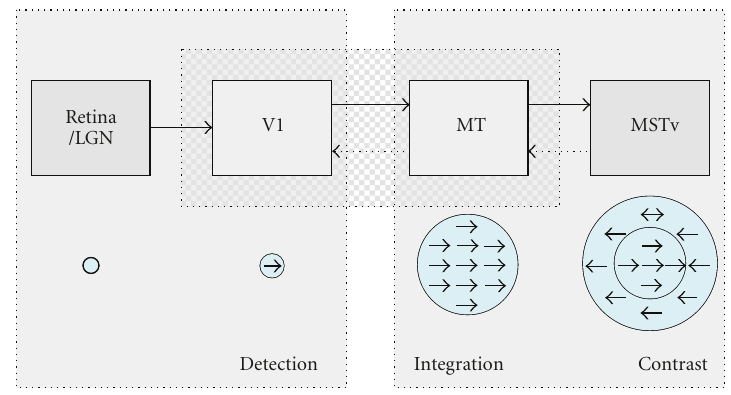
Figure 5: Box-and-arrow representation presenting an overview of neural connection and interaction scheme based on di ff erent cortical areas. Input images are fed forward from LGN into model area V1, where they undergo a filtering with a bank of orientation selective filters to extract local structure in an image frame. Performing a spatiotemporal correlation with these local response energies generates an initial motion signal which is forwarded to model area MT. In area MT a population code is generated to encode motion speed and direction. This integrated motion signal is further delivered to model area MSTv that may detect discontinuities in the flow field of motion vectors. The modelling framework presented here focuses on the interactive processing of motion information at the level of areas V1 and MT. We have highlighted this by the dashed grey box in the center of the figure. See text for further